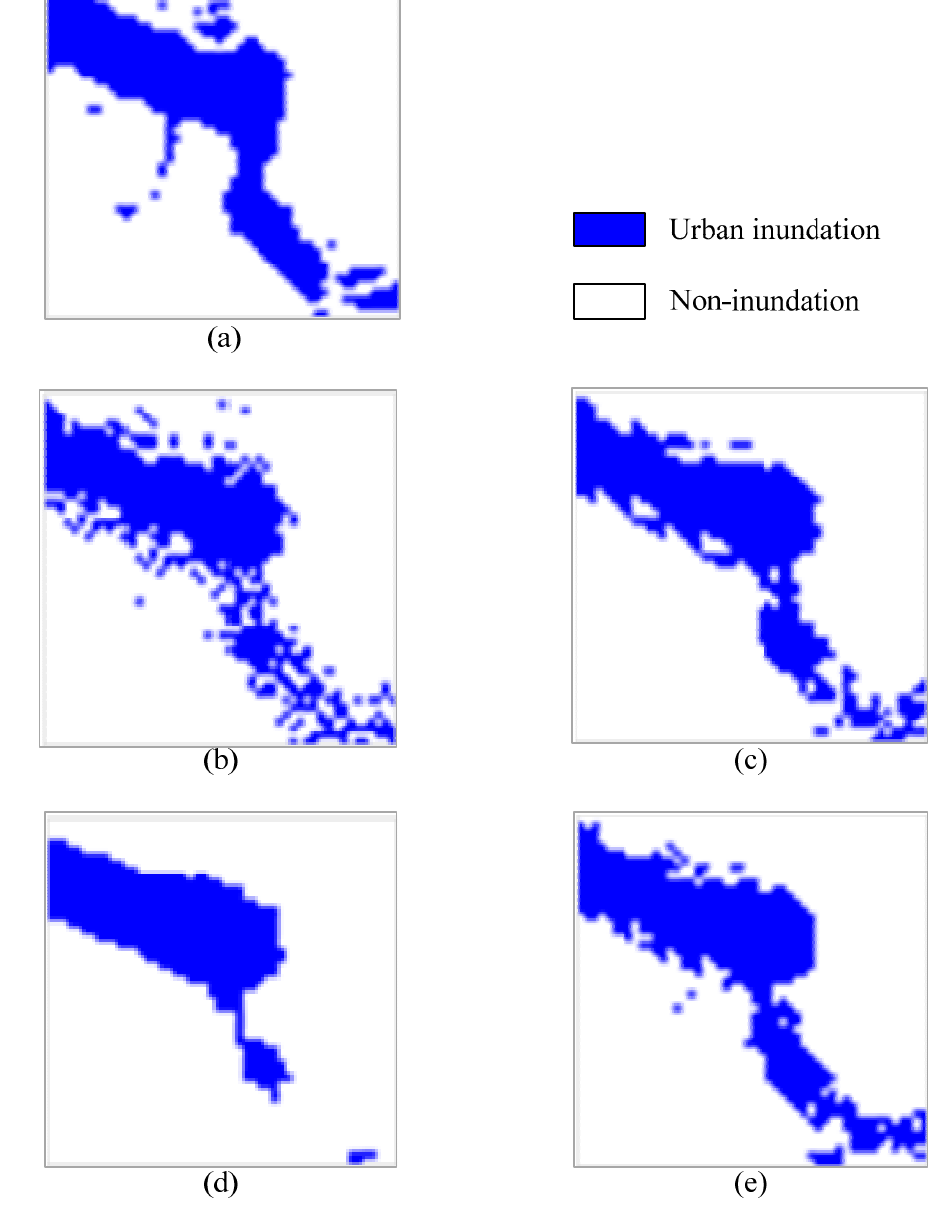
Figure 10. Zoom for small part 2 of inundation reference image and di ff erent SUIM results for Yueyang. ( a ) Inundation reference image; ( b ) BPNN-SUIM; ( c ) SVM-SUIM; ( d ) SAM-SUIM; ( e ) SAMENN-SUIM.